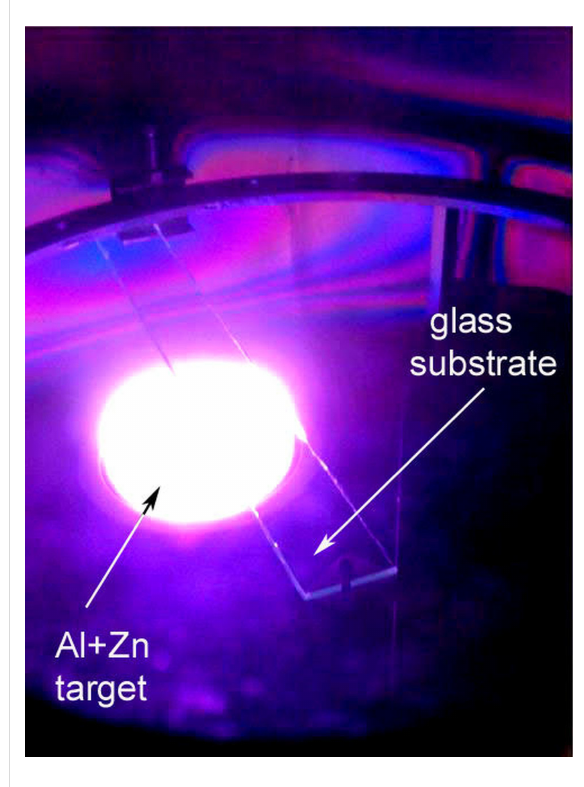
Figure 1: Schematic diagram of a sputtering system for the deposition of Al x Zn y O films.